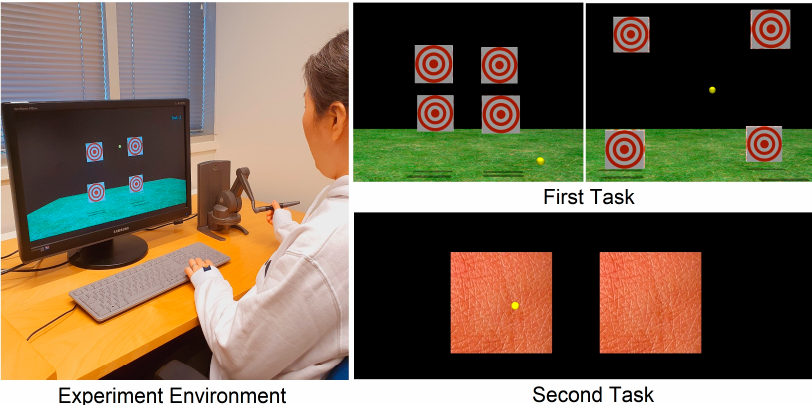
Figure 2. Experiment environment with two kinesthetic tasks shown on the display screen, and the left image of the first task is an example of the easy-to-reach task and the right one is an example of the difficult-to-reach